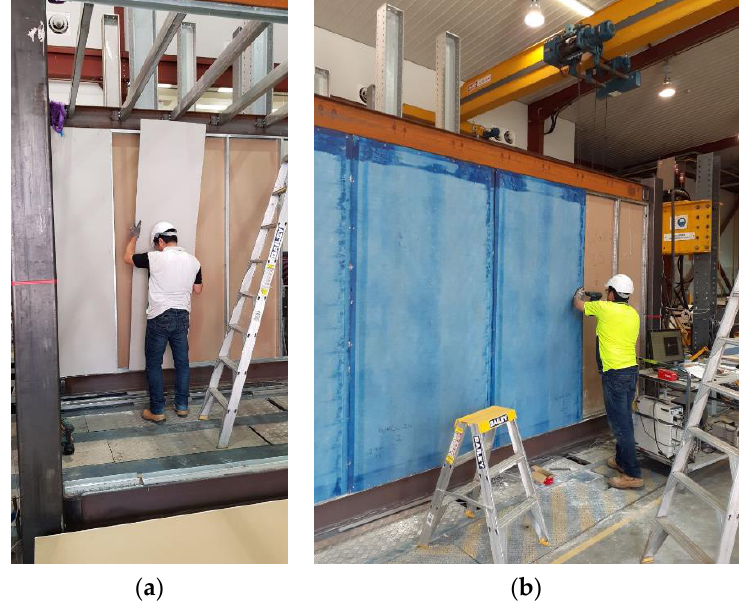
Figure 5. ( a ) Representative interior wall with gypsum plasterboards on both sides of the studs, ( b ) exterior wall with gypsum-board on inner side and cement-board at outer